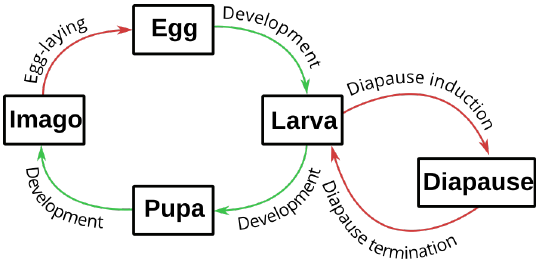
Figure 2. Schematic representation of the life cycle of the four maize stemborers we focused on in this study ( Chilo partellus , Busseola fusca , Sesamia nonagrioides , Ostrinia nubilalis ). The four species are Lepidoptera with a holometabolous development in four stages (egg, larva, pupa and imago). The number of generations per year varies between species and between populations of each